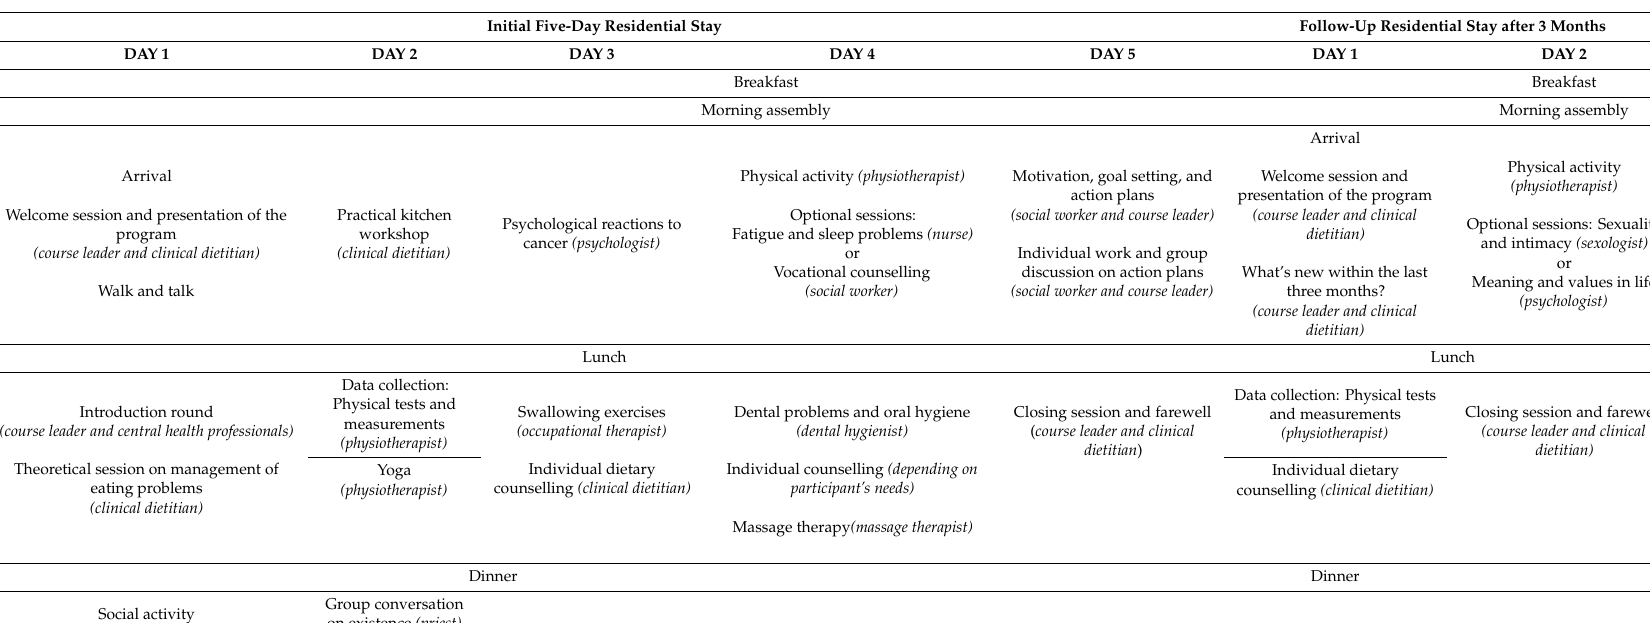
Table 1. Schedule for the initial five-day stay and two-day follow-up of the multidisciplinary residential nutritional rehabilitation program in the NUTRI-HAB